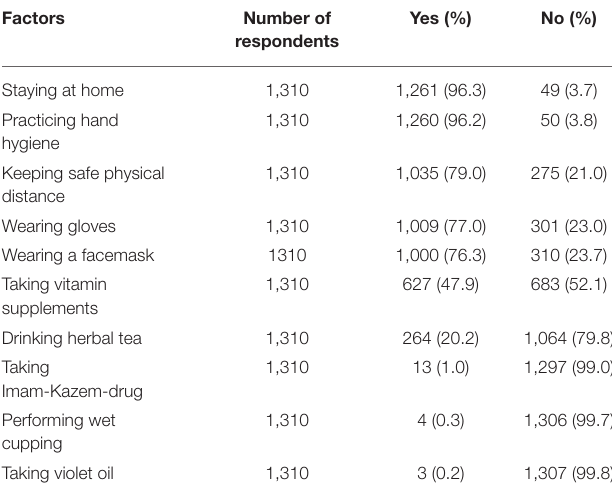
TABLE 7 | Preventive measures of healthcare workers for